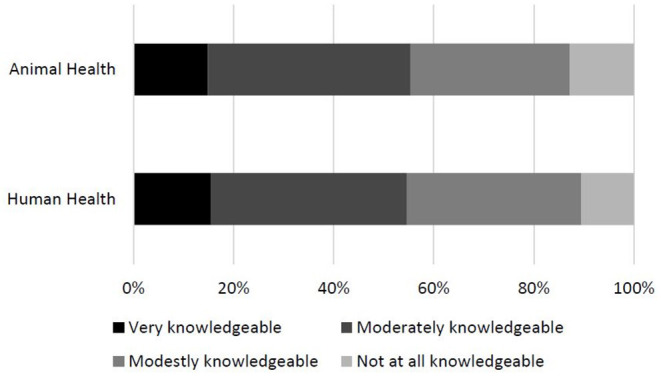
Percentage of veterinarian, self-reported knowledge on the association between climate change and human and animal health (n = 544).